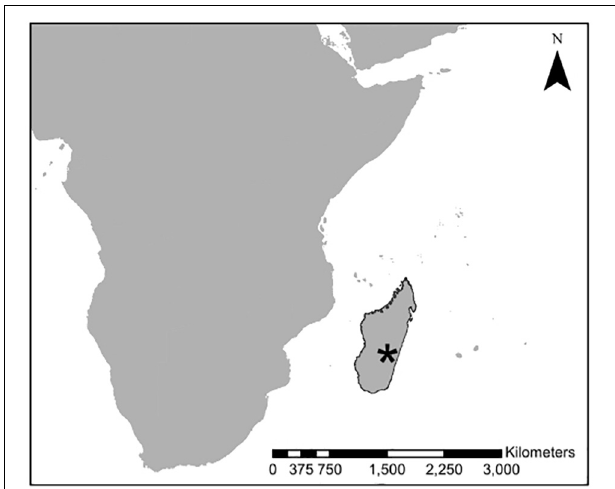
FIGURE 1 | Map of Madagascar showing the location of Ranomafana National Park as an asterisk.